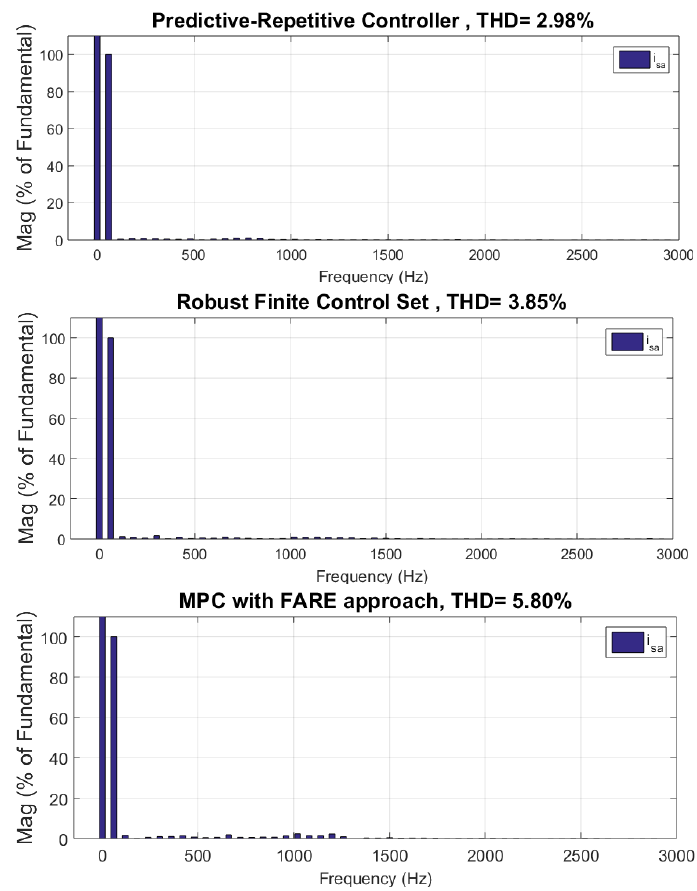
Figure 13. Comparison of the stator currents THD of the proposal and other strategies